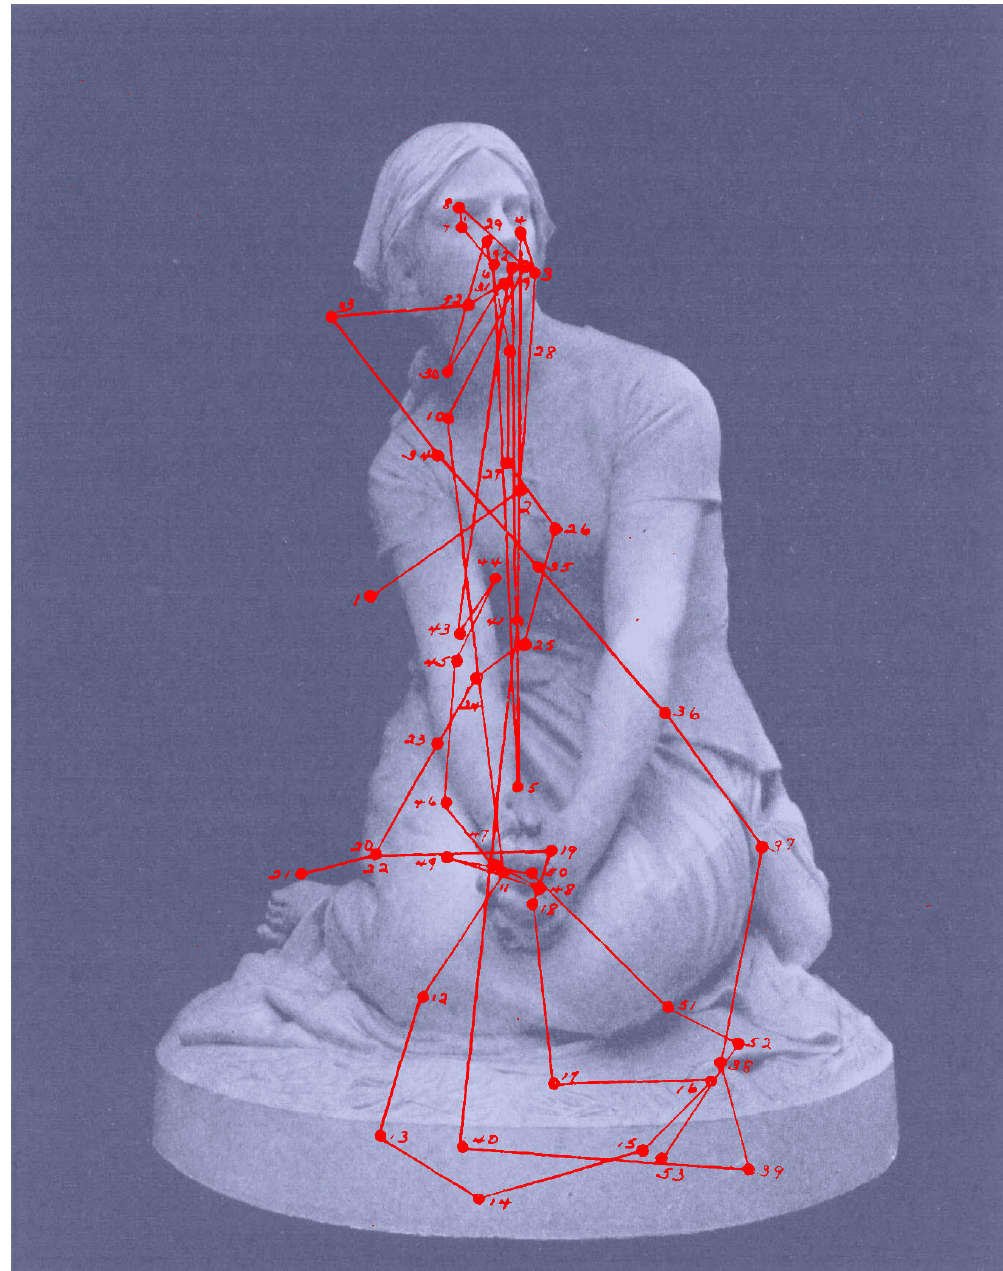
Figure 14. Facial fixation . Eye movements of one observer viewing a photograph of Statue of Joan of Arc by Henri-Michel- Antoine Chapu. (Adapted from Picture 31 and Plate XXXIV from Buswell,